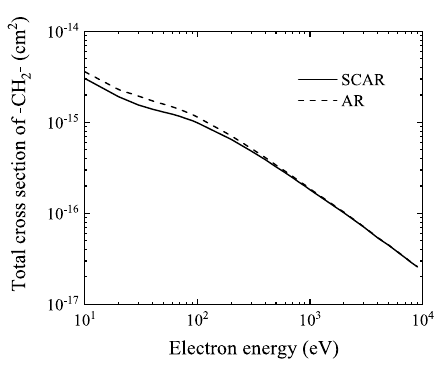
Figure 4. Total cross section of CH 2 at di ff erent incident electron energy